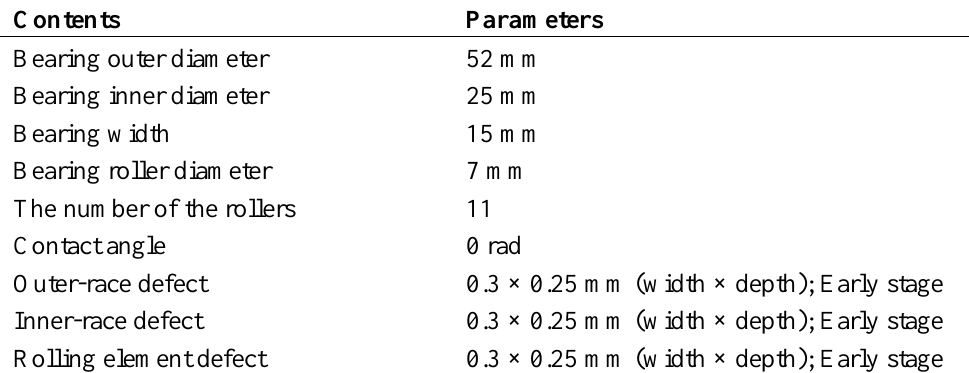
Table 1. Bearing information for verification.